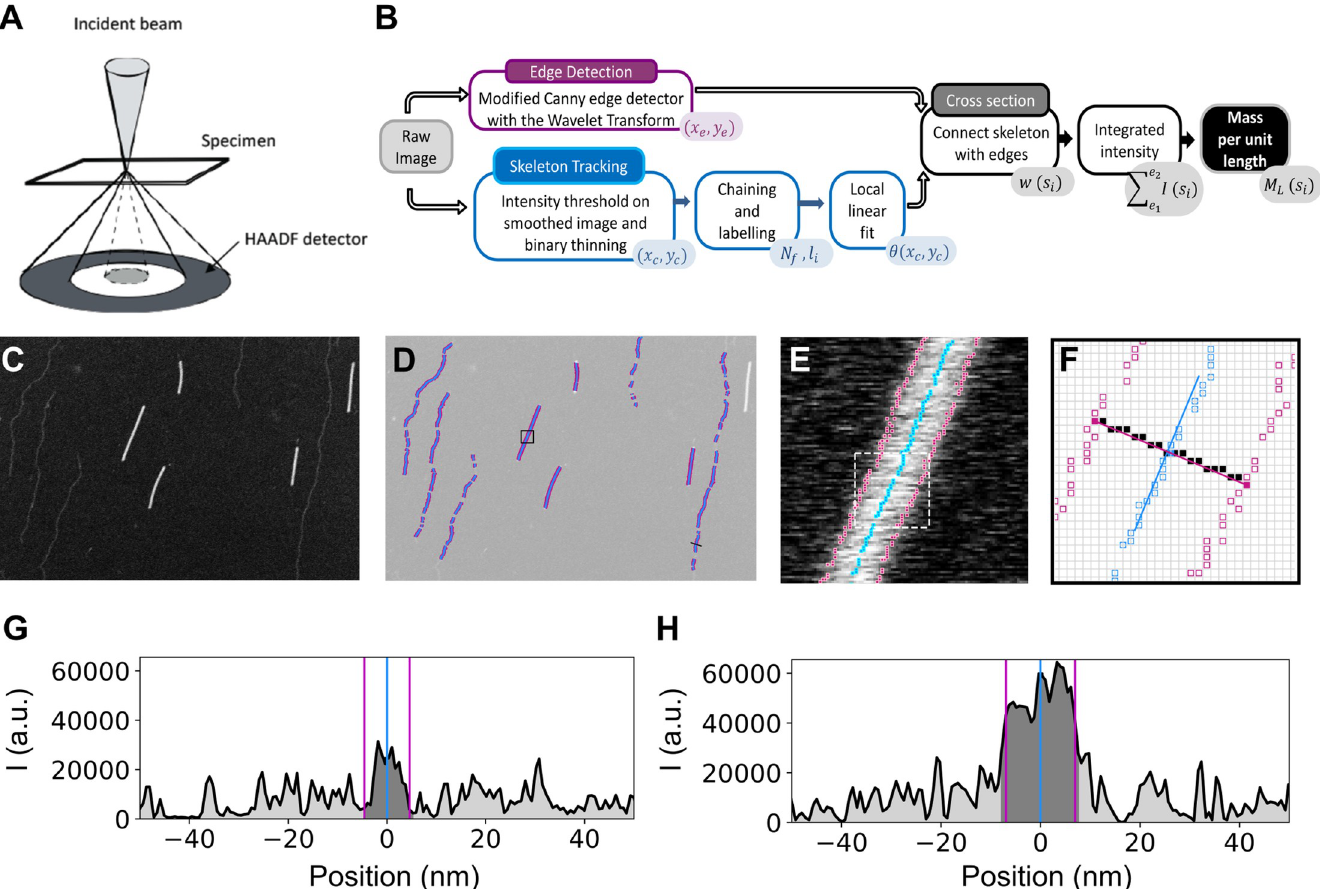
Fig 1. Overview of the method for filament tracking and mass-per-length ( M ) computation. (A) Scheme of the HAAFD mode, where the incident electrons are L scattered by the specimen and collected at high angles with an angular detector. (B) Algorithm workflow showing the steps and the corresponding output (color-filled text boxes in the lower right corners). (C) Unprocessed image of TMV rods (bright short rods) and Fd bacteriophages (dim long filaments) serving as input in this example. (D) Tracked edges (magenta) and skeleton (blue) points, used to compute the M L . Only the filament segments with a clean background and without intensity saturation are retained. (E) Image inside the black square shown in (D), with the tracked points overlaid. (F) Tracked edges and skeleton points inside the dashed white square shown in (E). The blue line shows the linear fit to the skeleton point in the center while the corresponding cross section is shown in magenta. The solid black squares represent the pixels in the filament cross section. (G) Intensity profile of the cross-section of the TMV rod in (F). The vertical lines show the detected edges and skeleton. Dark and light grey represent the integrated intensity for the filament and the background, respectively. (H) Same as (G) for an Fd filament indicated with a black line in